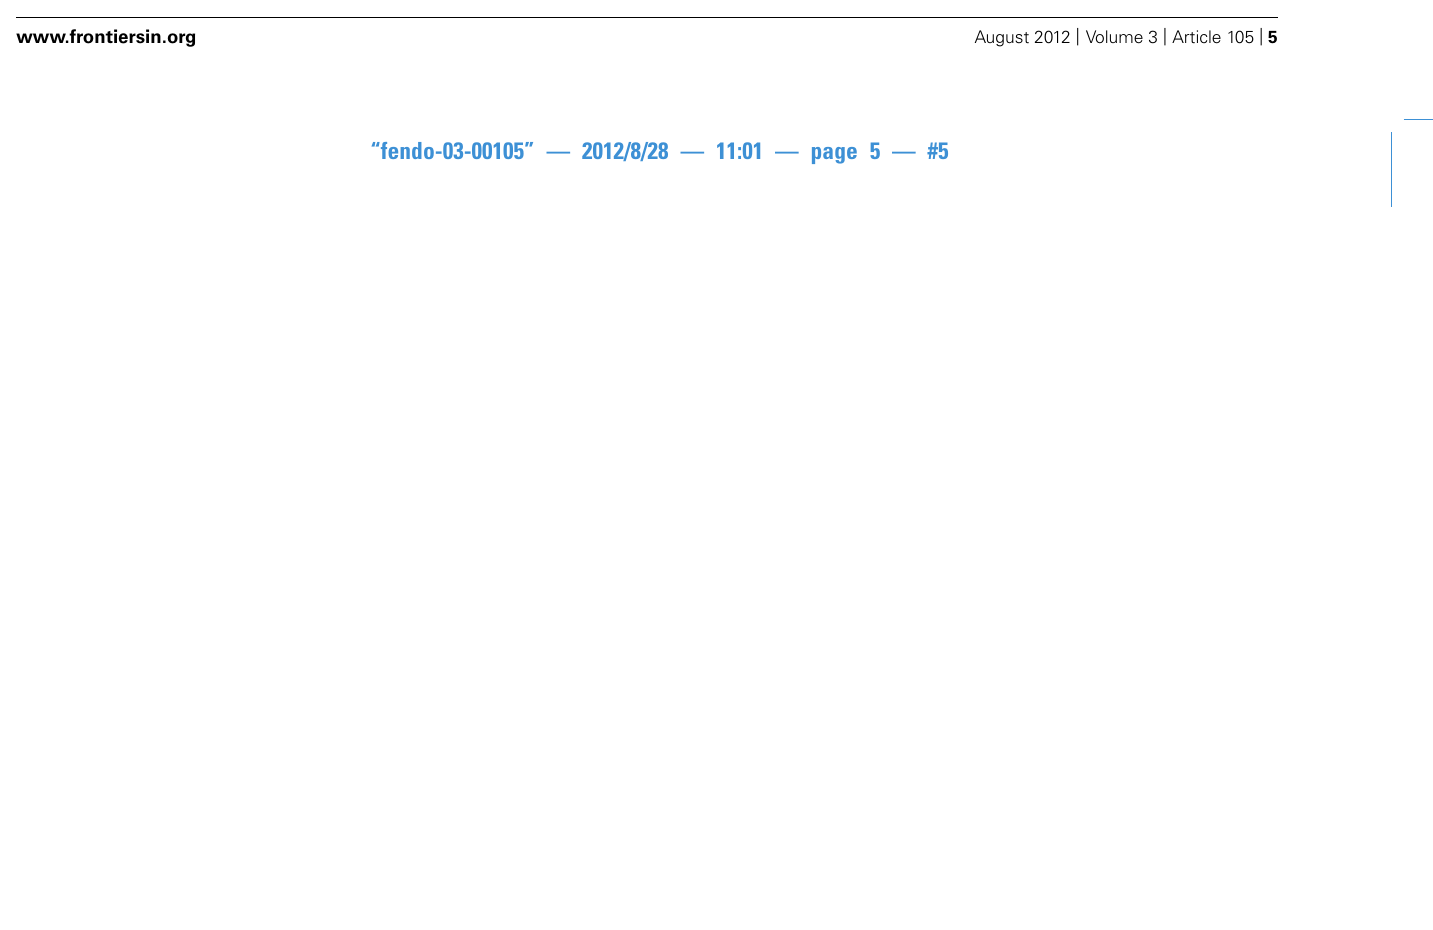
transfected with EPAC andTAAR1. BRET ratio is measured asYFP/Rluc ratio and the readings are started right after β -PEA addition. Cells are exposed to different concentration of β -PEA (from 1 nM to 100 μ M) or control medium. The decrease in BRET ratio indicates an increase in cAMP concentration. β -PEA induces a robust increase in cAMP level that lasts along the duration of the entire experiment (20 min). (C) Dose–response of β -PEA effect on TAAR1-dependent cAMP accumulation after 10 min of